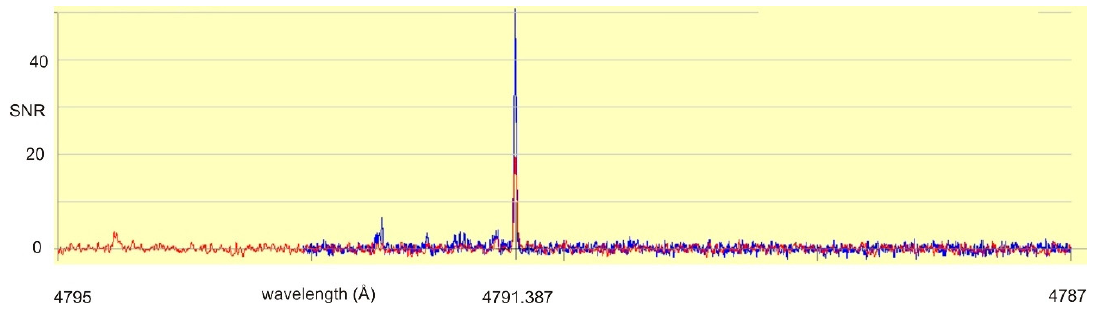
Figure 3. Fourier-transform spectrum in the wavelength range of the observed (“negative”) fluorescence line (4792 ± 2 Å). There is only one strong line, which can be classified as transition between an odd-parity level with medium energy (23,874.946 cm − 1 ) and an even-parity metastable low-lying level (3009.993 cm − 1 ). Due to experience, only intense lines of such type act as “negative” fluorescence lines.